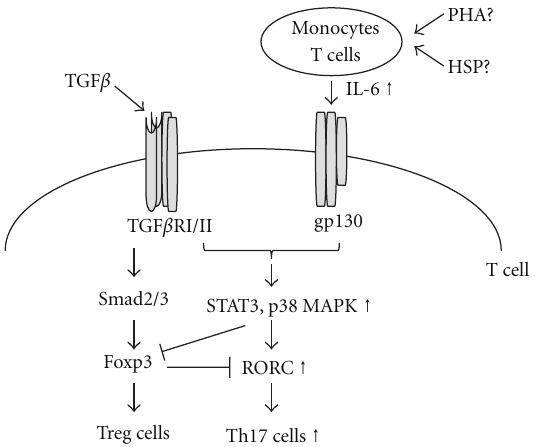
Figure 3: A schematic representation of skewed Th17/Treg cell di ff erentiation in patients with BD, a hypothesis. TGF β activates Smad pathway via TGF β receptor I/II complex, and activated Smad protein leads to forkhead box P3 (Foxp3) expression which is a master gene of Treg cells [27]. TGF β also activates p38 mitogen-activated protein kinase (MAPK) which regulates Th17 cell di ff erentiation [32, 33]. In the presence of TGF β , IL-6/STAT3 signaling pathway plays a critical role in the reduction of Foxp3 expression and in the induction of retinoic acid receptor-related orphan receptor C (RORC) expression which is a master gene of Th17 cells [34]. In patients with BD, monocytes and T cells overproduce IL-6 in the presence of HSP [41]. Overexpression of RORC [42, 43], underexpression of Foxp3 [44, 45], and higher frequencies of Th17 cells [42–44, 46] are reported in patients with BD. PHA: phytohemagglutinin, TGF β RI/II: TGF β receptor types I and II, STAT3: signal transducer and activator of transcription 3.